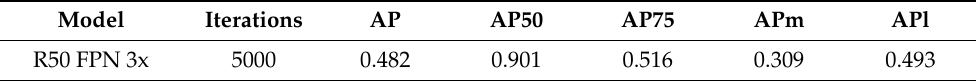
Table 1. Comparison of the Faster RCNN Model and Repeated Test Results (Bounding Box). Model Iterations